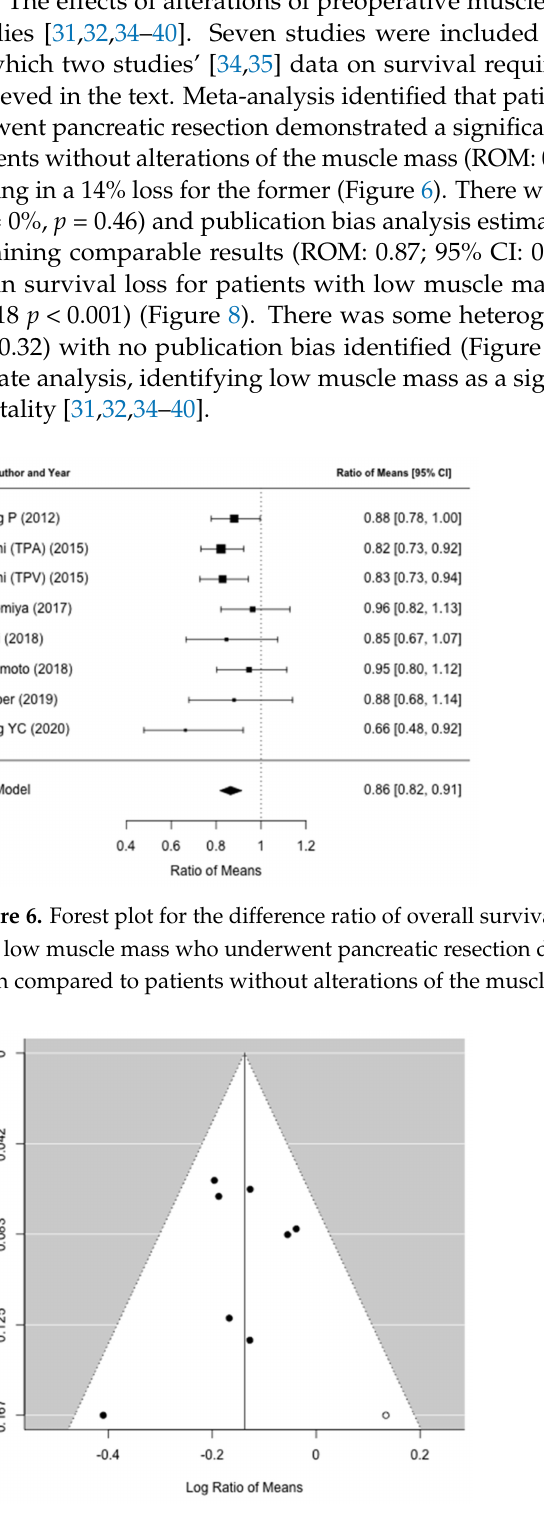
Figure 7. Funnel plot for the difference ratio of overall survival. Publication bias analysis estimated one study missing (white